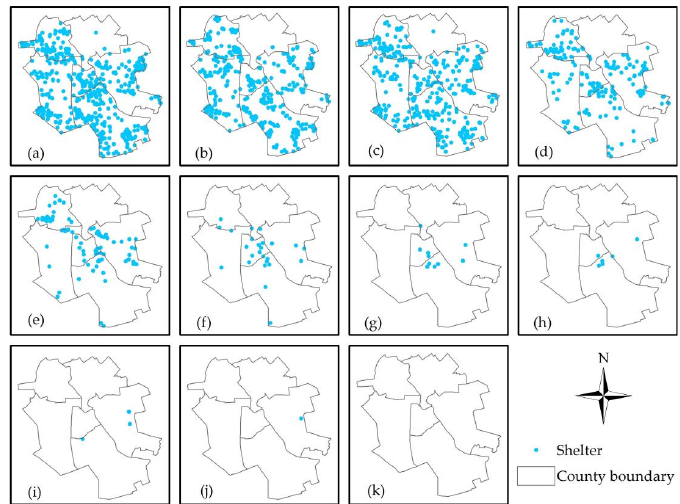
Figure 5. The distribution map of emergency shelters for which the catchment sizes need to be ad- justed. ( a ) The distribution of shelters whose catchment size are adjusted for the 1st time; ( b ) The distribution of shelters whose catchment size are adjusted for the 2nd time; ( c ) The distribution of shelters whose catchment size are adjusted for the 3rd time; ( d ) The distribution of shelters whose catchment size are adjusted for the 4th time; ( e ) The distribution of shelters whose catchment size are adjusted for the 5th time; ( f ) The distribution of shelters whose catchment size are adjusted for the 6th time; ( g ) The distribution of shelters whose catchment size are adjusted for the 7th time; ( h ) The distribution of shelters whose catchment size are adjusted for the 8th time; ( i ) The distribution of shelters whose catchment size are adjusted for the 9th time; ( j ) The distribution of shelter whose catchment size is adjusted for the 10th time; ( k ) there has none shelter’s catchment size need to be adjusted in the 11th time.